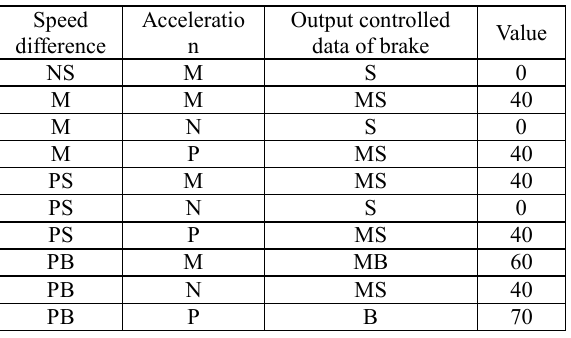
Table 2. Rulebase of brake